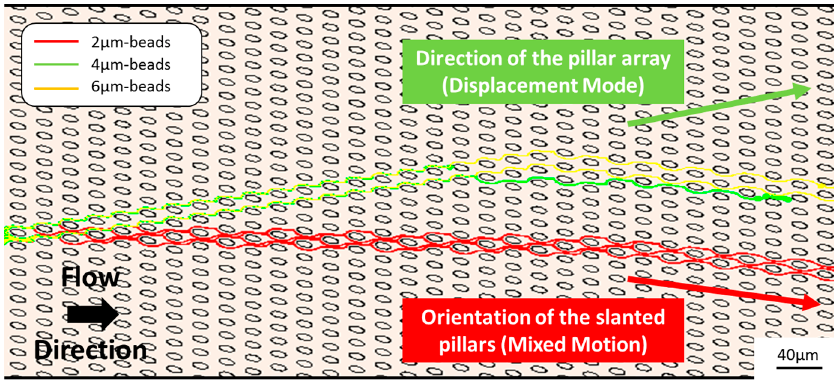
Figure 2. Trajectory modeling of 2 µm, 4 µm and 6 µm beads in an array of slanted elipsoidal pillars.